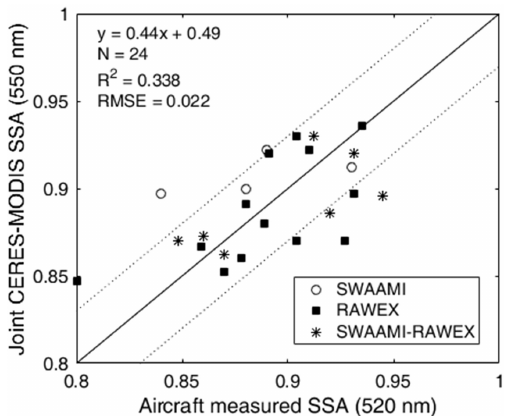
Figure 6. Comparison of combined CERES-MODIS SSA with aircraft measurements during SWAAMI, RAWEX, and SWAAMI- RAWEX campaigns. The solid line shows the ideal 1 : 1 case and dotted lines represent the absolute difference of